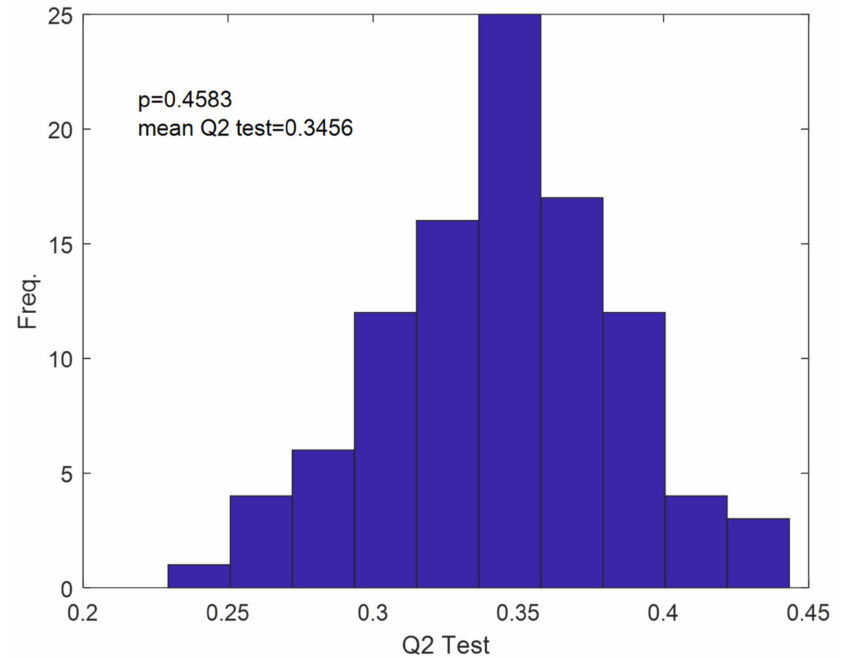
Figure A5. Monte Carlo permutation test (MCPT) showing Q 2 obtained from RF regression models developed on the test set, the number of repetitions was n = 100. The mean value of Q 2 was 0.3456 at the significance level p =